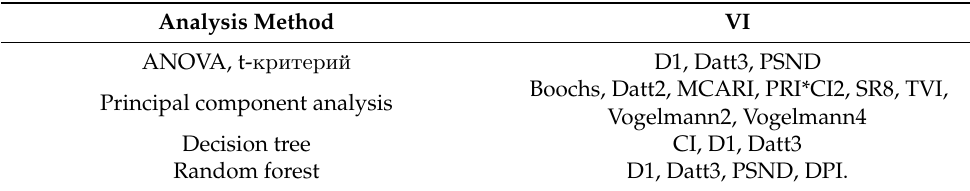
Table 17. Best VIs for weeds